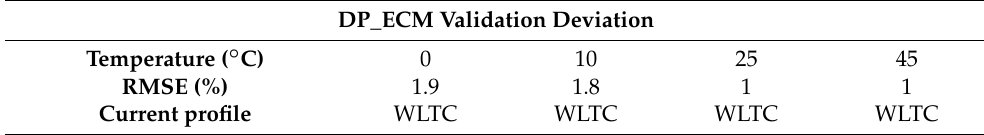
Table 1. Summary of RMSE deviation of DP_ECM electrical model.